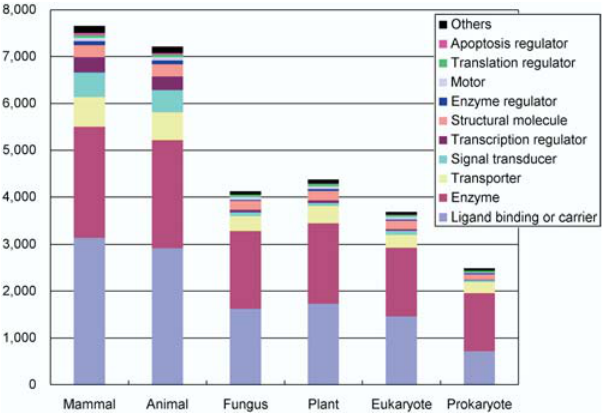
Figure 6. The Functional Classification of H-Inv Proteins That Are Homologous to Proteins in Each Taxonomic Group The numbers of representative H-Inv cDNAs with sequence homology to other species’ proteins ( E , 10 (cid:1) 5 ) were calculated. The cDNAs for which we could not assign any functions were discarded. Mammalian species were excluded from the ‘‘ animal ’’ group. ‘‘ Eukaryote ’’ represents eukaryotic species other than those included in the mammal, animal, fungi, and plant groups. See also Table S7. DOI: